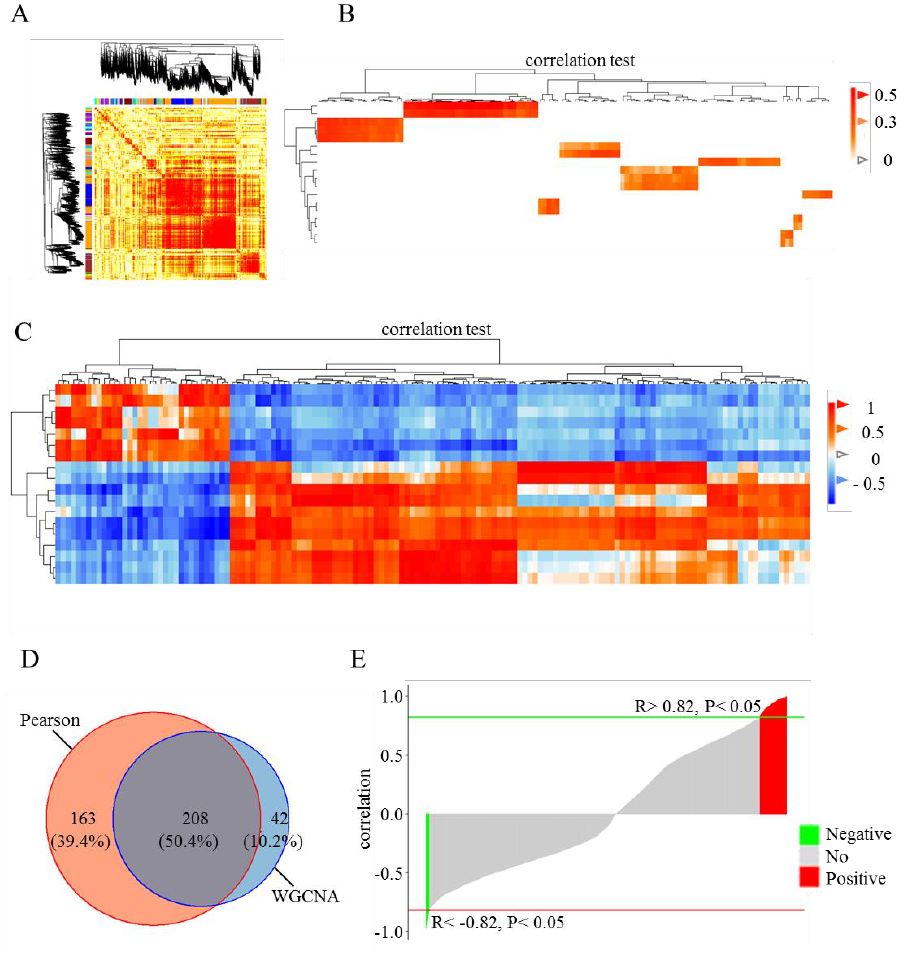
Figure 3. Correlation analysis of DE genes and lincRNAs in the adipose tissues of high- and low-FE pigs. Weighted correlation network analysis (WGCNA) was applied to identify modules of highly correlated factors, including genes and lincRNAs. ( A ) A total of 25 modules were identified on the basis of expression patterns, which are represented by the dendrogram and correlation heat map. ( B ) Correlations between differentially expressed (DE) genes and lincRNAs were identified through WGCNA. Dark color indicates higher correlation. Vertical and horizontal axes in the heat map represent lincRNAs and genes, respectively. ( C ) Correlations between DE genes and lincRNAs were estimated on the basis of the Pearson correlation coefficient. Lattices in red are highly positive, and those in blue are highly negative. ( D ) Venn diagram depicting the proportion of correlated lincRNA-gene pairs detected on the basis of WGCNA and Pearson correlation. ( E ) Bar plot showing the Pearson correlation coefficient of overlapping lincRNA-gene pairs. Red and green bar plots represent positively and negatively correlated pairs,